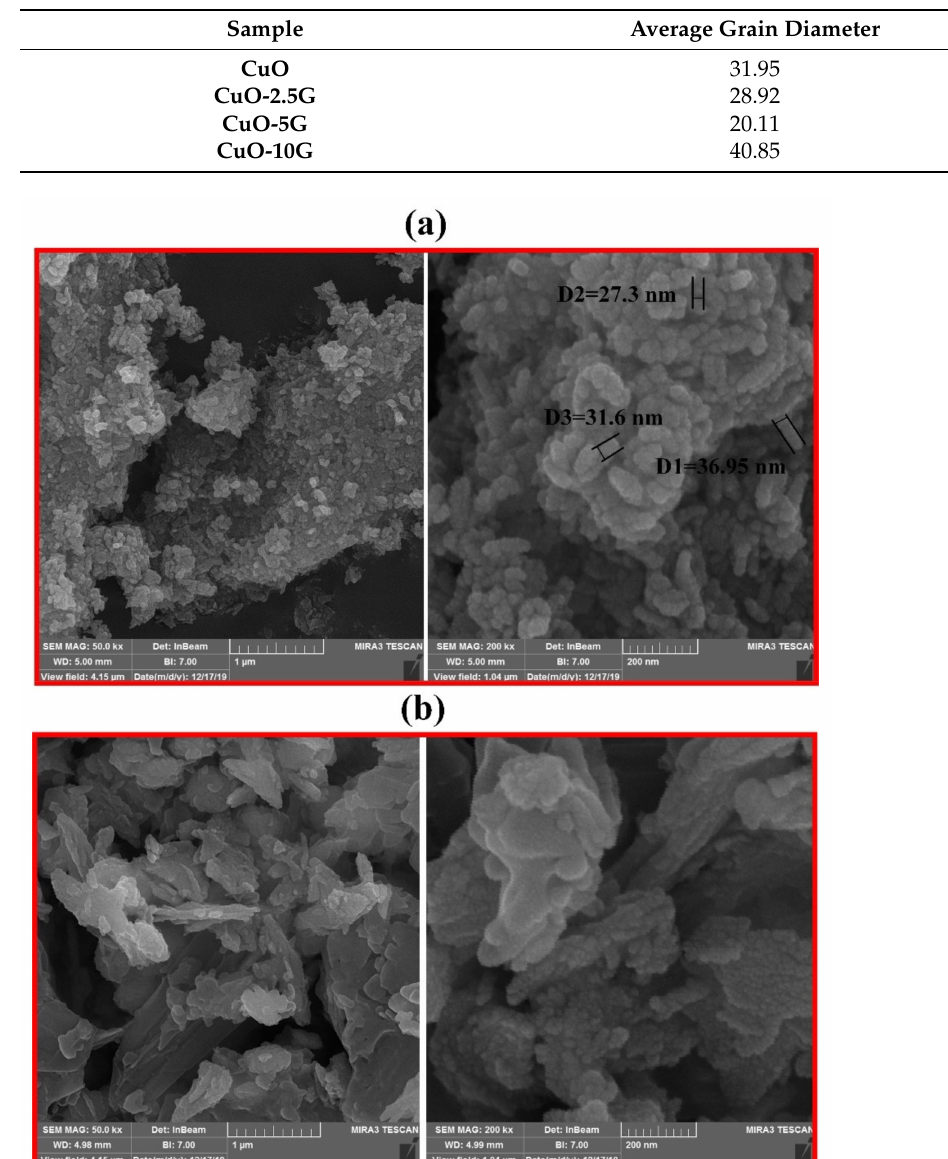
Figure 2. FESEM images of the samples: ( a ) CuO and ( b )